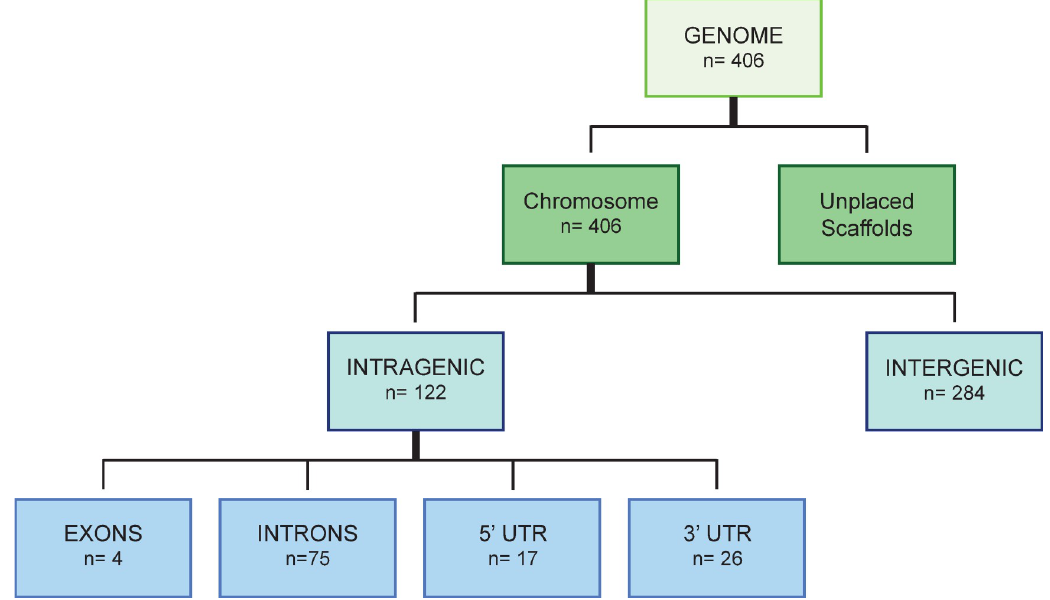
Fig 1. Flowchart for identifying PQS found in the S . mansoni genome. Quadparser and G4Hunter were used to independently identify PGS within the S . mansoni genome (v7.1). The Bedtools intersect function was subsequently used to find overlapping PQS detected by both methods. Across the assembled chromosome scaffolds (genome), this led to the discovery of 406 PQS. Unplaced scaffolds were not included in the analysis. Intragenic PQS analysis, determined using the genome annotation file, found 122 of these to be within either Exons (4), Introns (75), 5´ UTRs (17) or 3´ UTRs (26). Those PQS deemed intergenic are found within chromosomes but not within intragenic